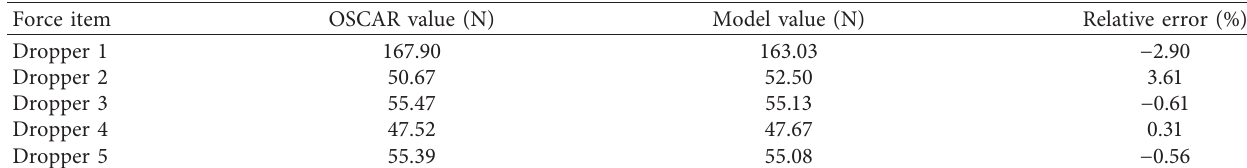
Table 2: Dropper forces results of the model against the OSCAR.